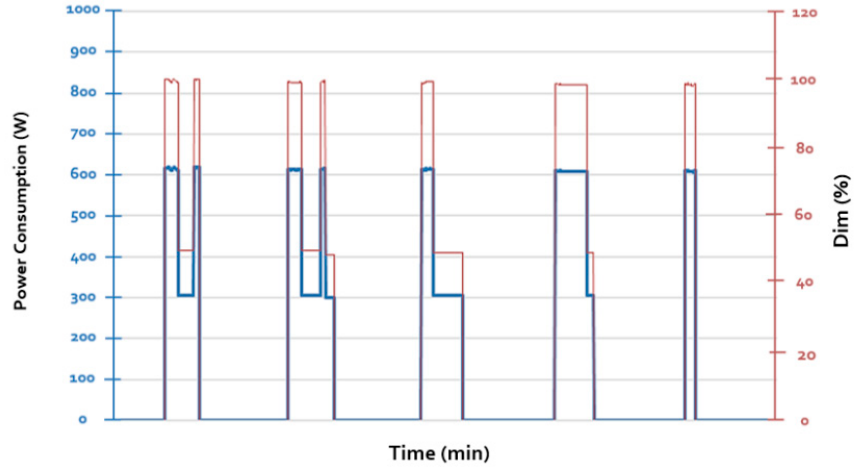
Figure 8. Lighting consumption profile with dimming (10-min level granularity).